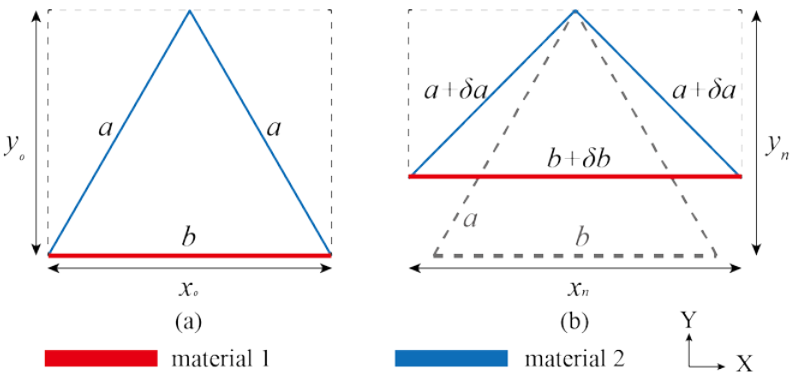
Figure 1. Schematic illustration of the thermal expansion deformation of a triangle cell: ( a ) initial shape ( b ) shape after heating. shape ( b ) shape after